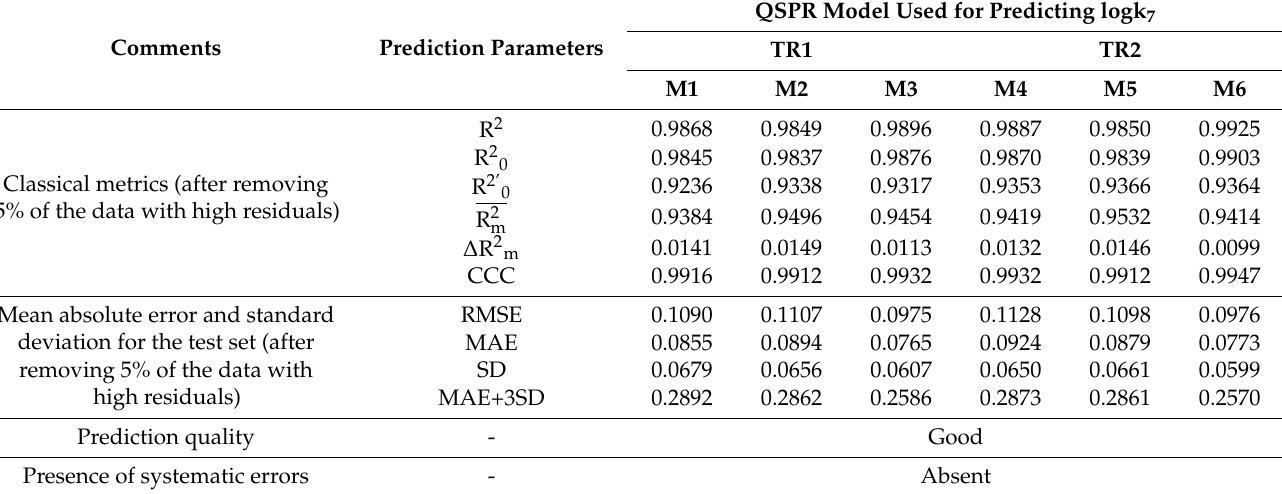
Table 2. Validation parameters of the QSPR models estimated using the Xternal Validation Plus 1.2 program based on the experimental and predicted logk 7 values of the compounds of the internal